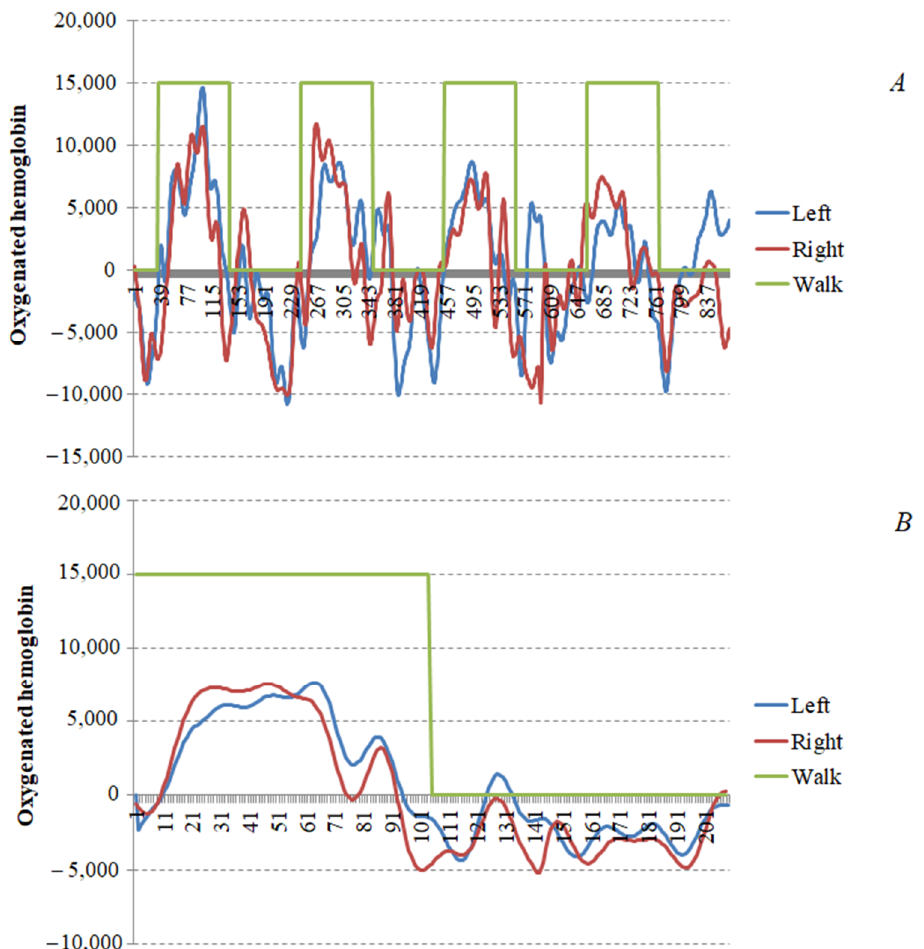
Figure 1. Method of calculation of cortical activation. ( A ): mean track of the 24 channels for each hemisphere during the 4 walking tasks (represented in green); ( B ): mean of the four walking tasks. Cortical activation was calculated as the area under the curve for both hemispheres, as in ( B ).